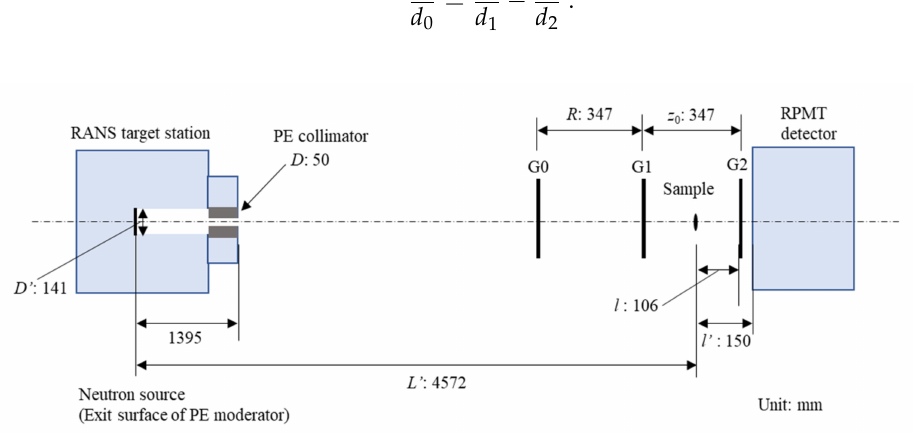
Figure 2. Layout of the Talbot–Lau interferometer with